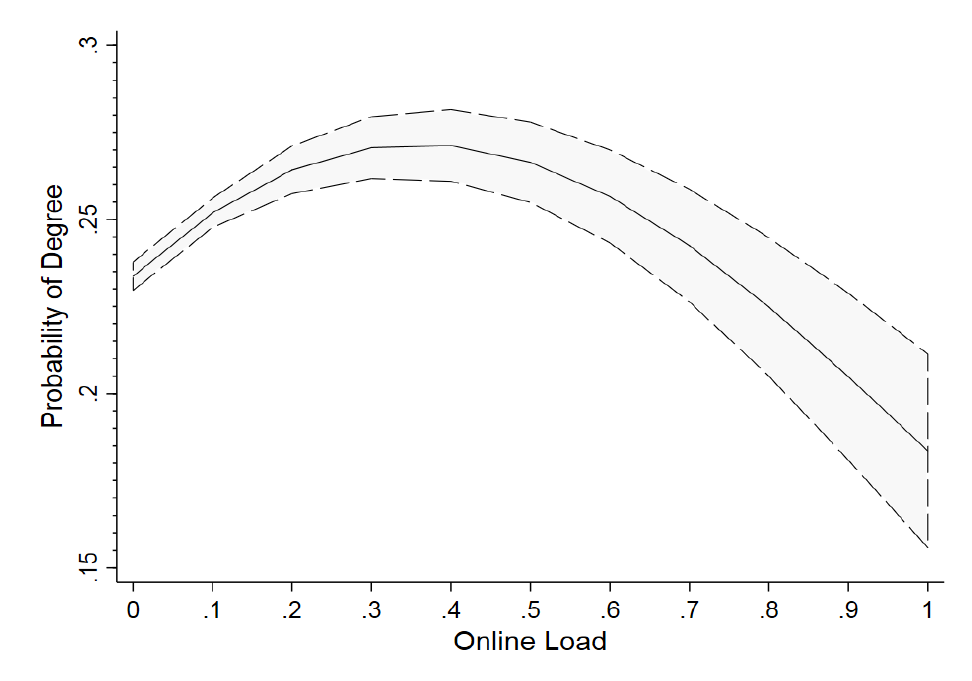
Figure 1. Effect of online course load on degree completion.